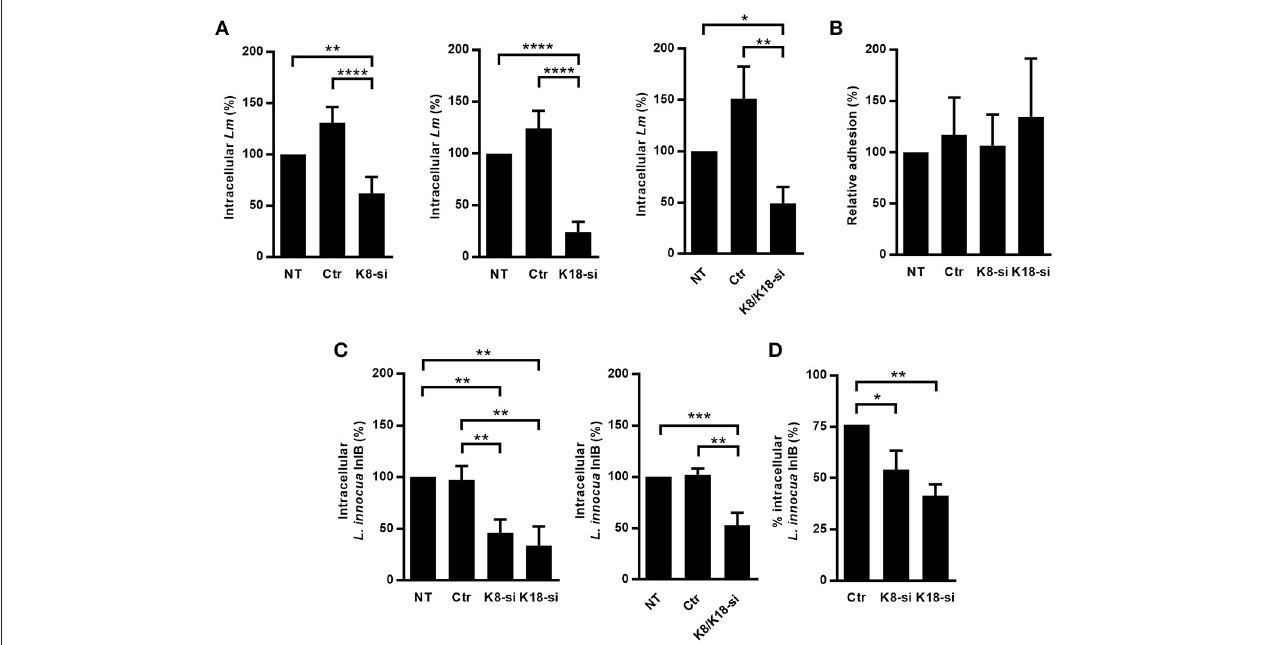
FIGURE 1 | K8 and K18 promote Listeria infection of HeLa cells. (A) Intracellular levels of L. monocytogenes were determined by gentamicin protection assay and CFU counting in HeLa cells left untransfected (NT) or transfected with either control (Ctr) or siRNA specifically targeting K8 (K8-si, left panel), K18 (K18-si, middle panel) and both (K8/K18-si, right panel). (B) Adhesion of L. monocytogenes was assessed in HeLa cells left unstransfected (NT) or transfected with Ctr, K8 or K18 siRNA. (C,D) Intracellular levels of L. innocua expressing InlB ( L. innocua InlB) were determined (C) by gentamicin protection assays and CFU counting in HeLa cells left unstransfected (NT) or transfected with Ctr or specific siRNA targeting K8 (K8-si left panel), K18 (K18-si, left panel) and both (K8/K18-si, right panel) or by (D) immunofluorescence scoring of extracellular and total bacteria. Values of intracellular or adherent bacteria in NT cells were normalized to 100% and the levels of infection in the remaining conditions are expressed as relative values. Values represent the mean ± S.E. of at least three independent experiments, each done in triplicate. Statistically significant differences are indicated: * p < 0.05, ** p < 0.01, *** p < 0.001, and **** p < 0.0001.